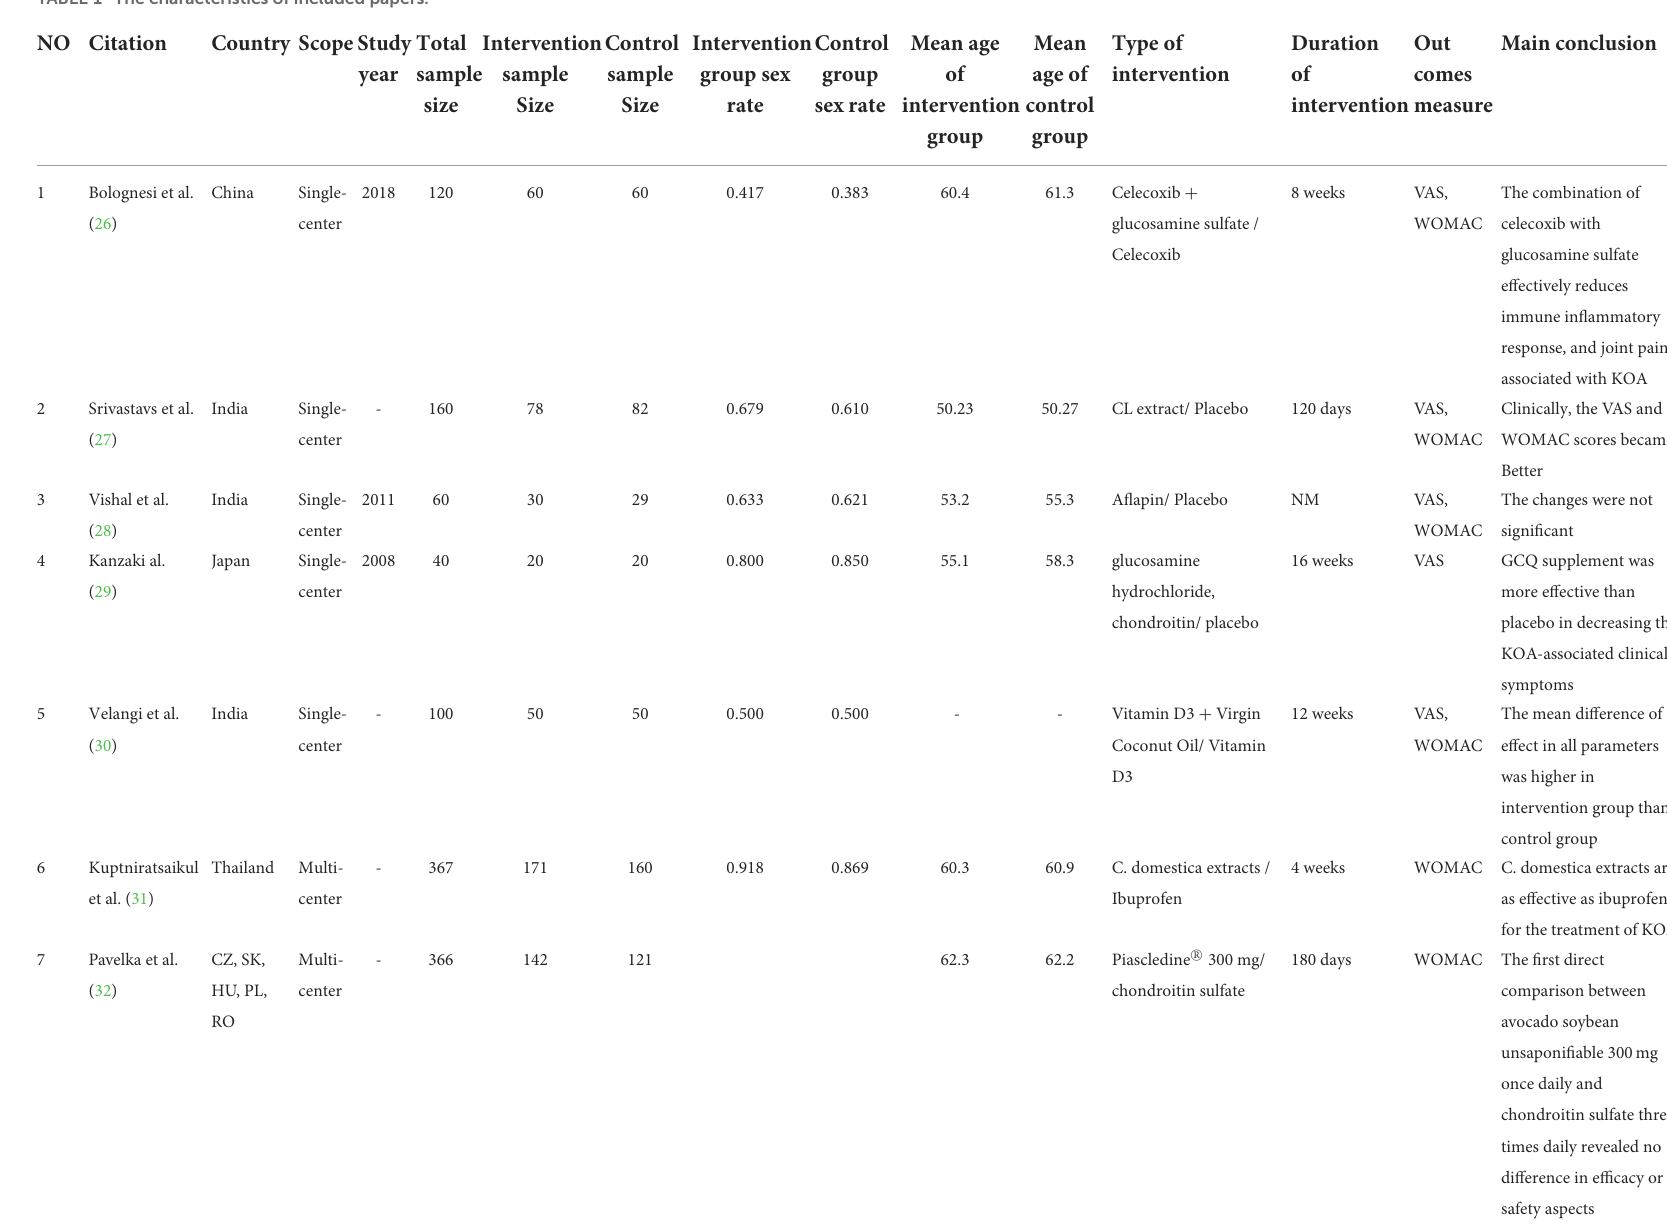
TABLE 1 The characteristics of included